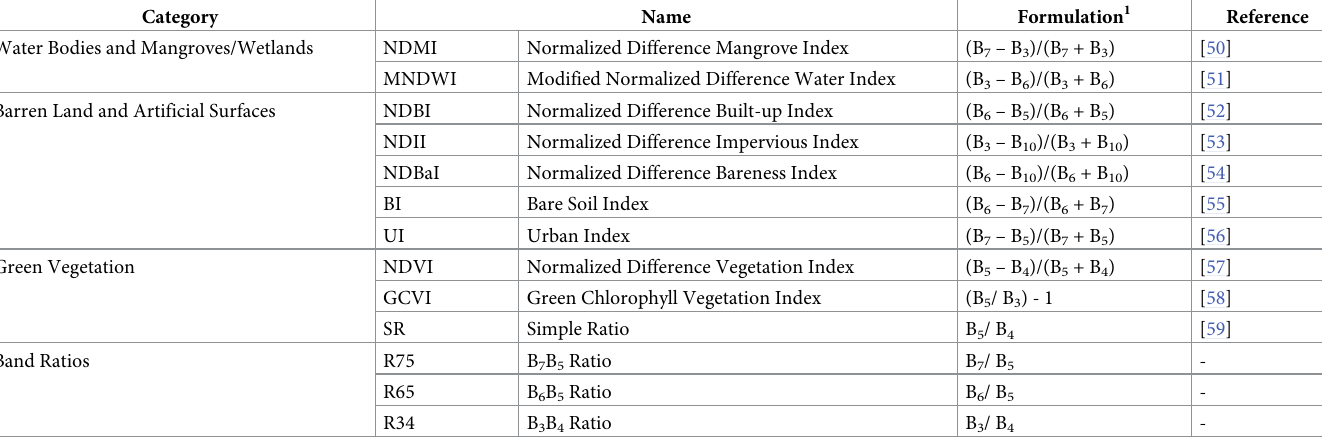
Table 3. Reflectance-based spectral indices used as predictors for masking phase and classification.